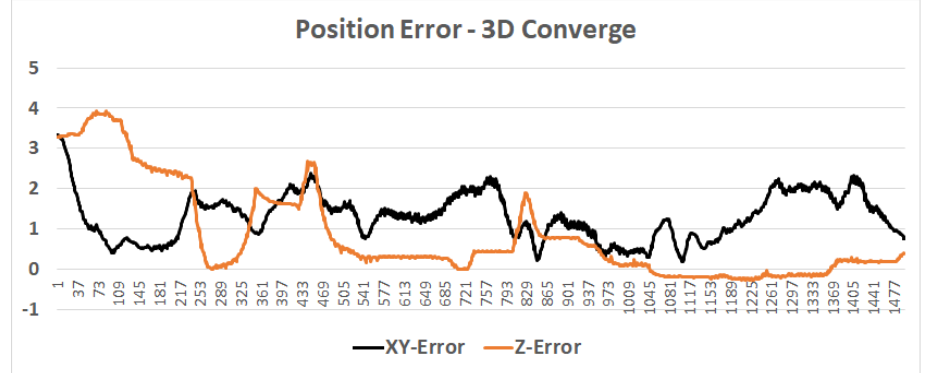
Figure 14. Particle filter 3 D convergence: an (about) 120 s test, in which the position converged from a height error of 4 m to a sub-meter; upon having the proper height, the horizontal position converged, as well.